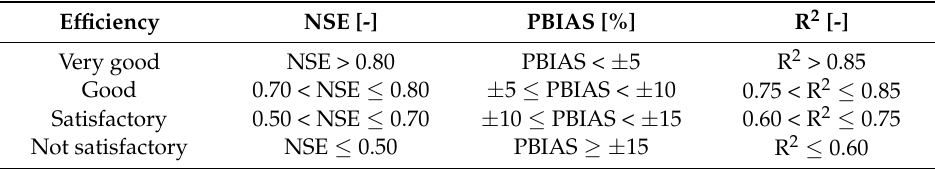
Table 1. Performance criteria according to Moriasi et al. [41].